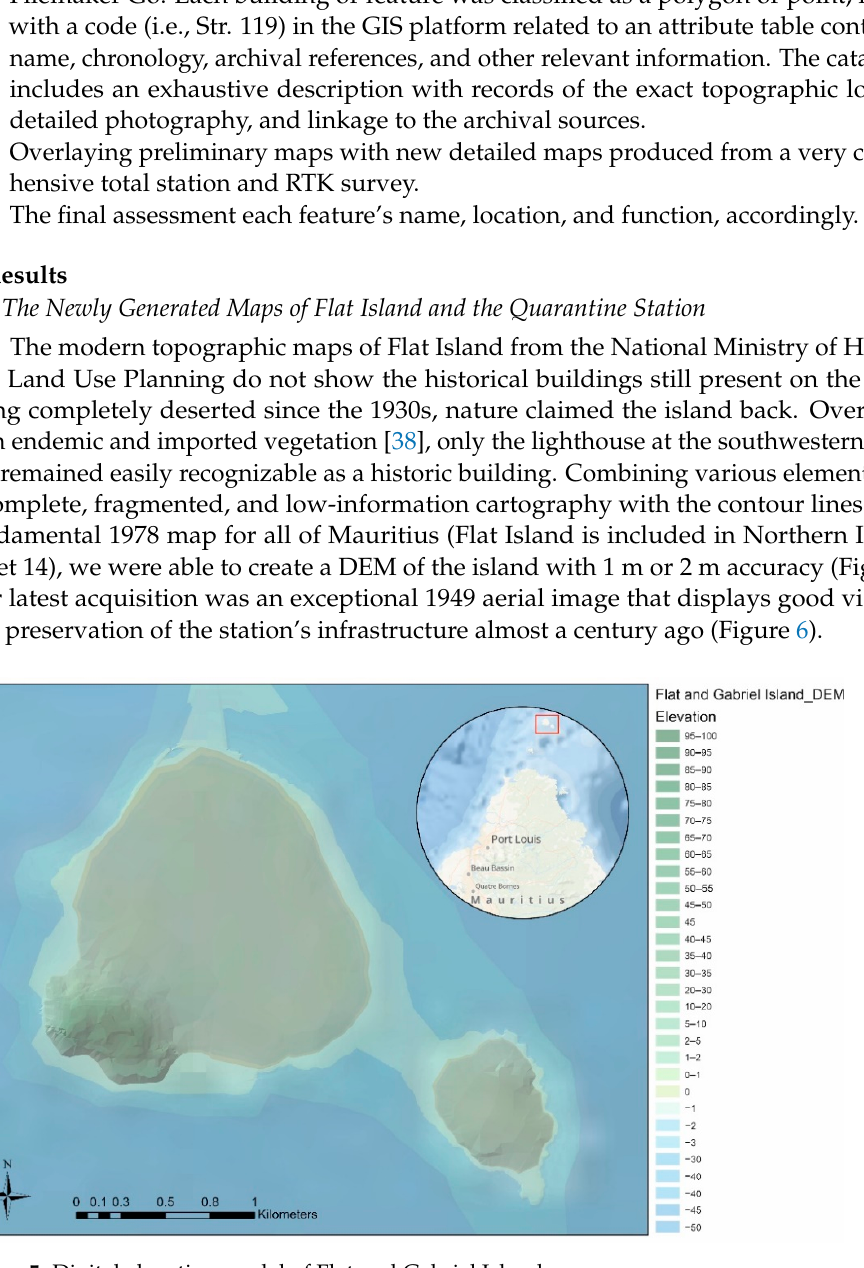
Figure 5. Digital elevation model of Flat and Gabriel Island.